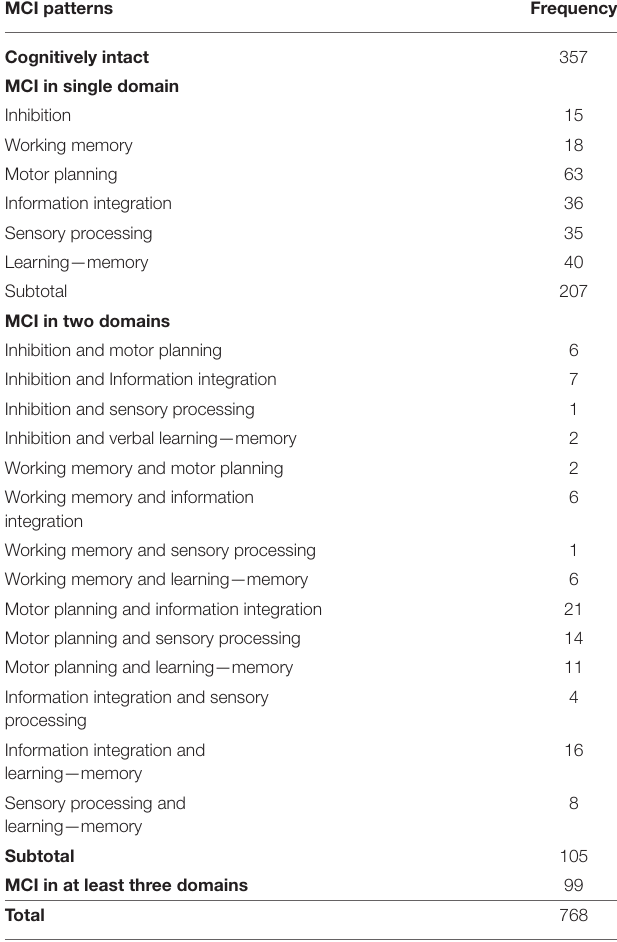
TABLE 1 | The frequency of MCI patterns at study entry